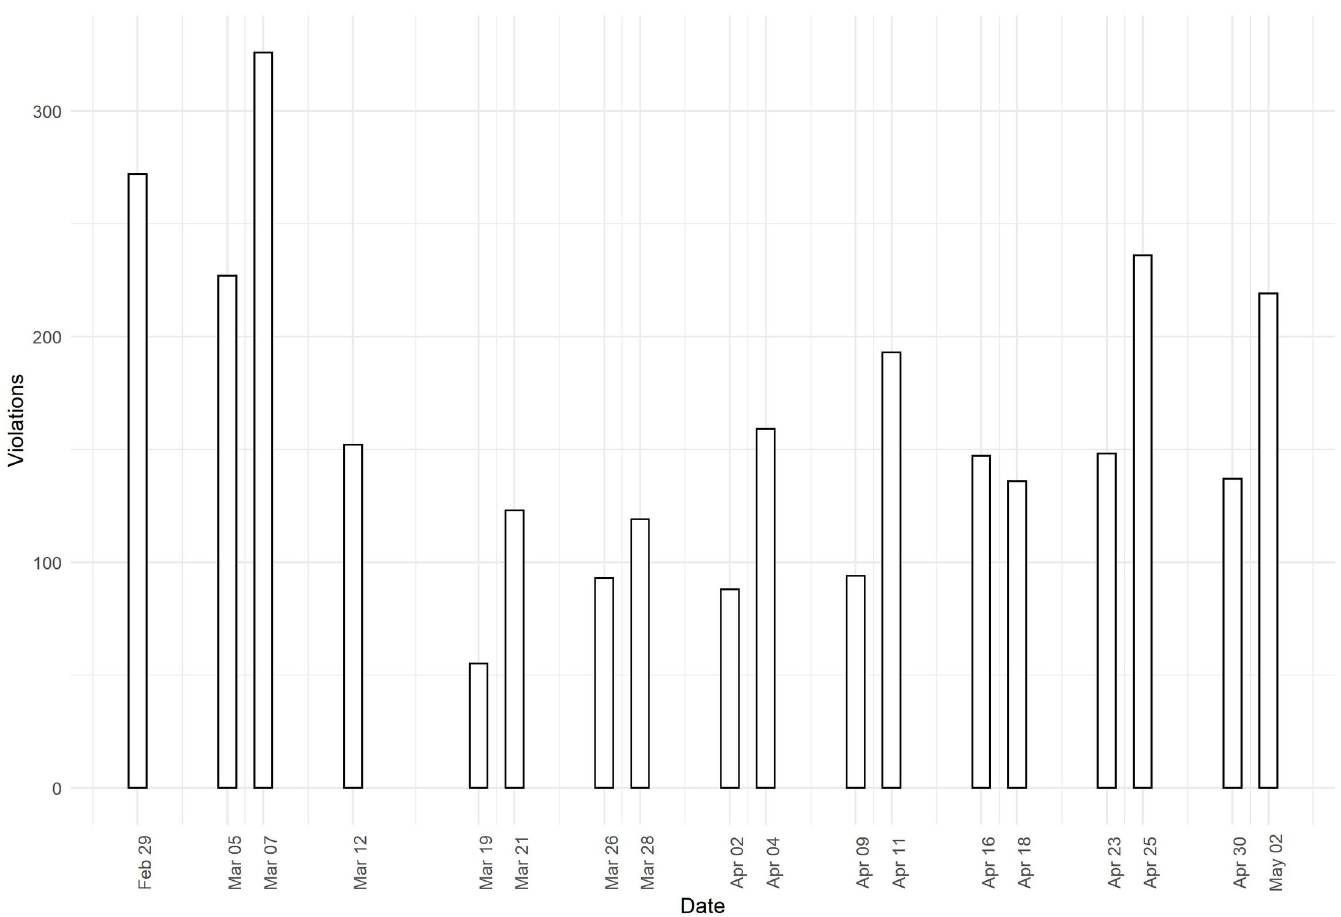
Fig 3. Observed social distancing violations (i.e., < 1.5 meter proximity by non-household members) from CCTV